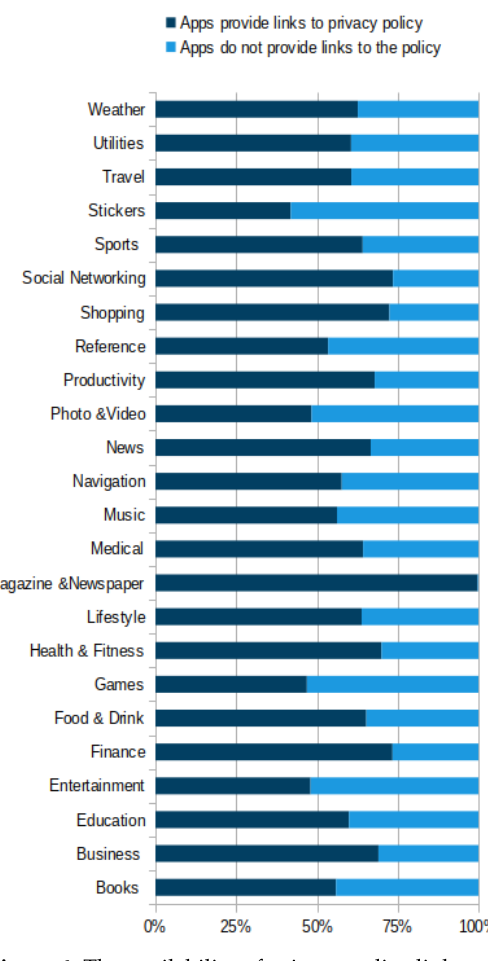
Figure 6. The availability of privacy policy link across the different app categories.